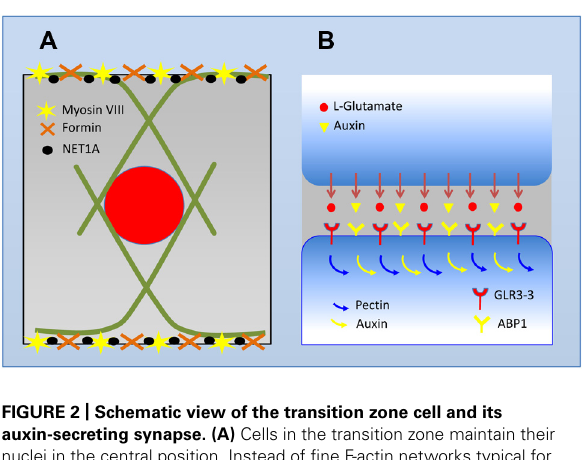
FIGURE 2 | Schematic view of the transition zone cell and its auxin-secreting synapse. (A) Cells in the transition zone maintain their nuclei in the central position. Instead of fine F-actin networks typical for meristematic cells, these cells develop prominent bundles of F-actin which enclose the nucleus in a cage-like structures. Inhibition of endocytic vesicle recycling with brefeldin A results in a disintegration of this F-actin cage and nuclei are shifted out of their central position (Baluška and Hlavacka, 2005). At the plasma membrane, F-actin bundles are anchored at F-actin rich end-poles which are active in endocytosis/endocytic vesicle reycling. Anchoring of F-actin bundles at the plasma membrane and support of